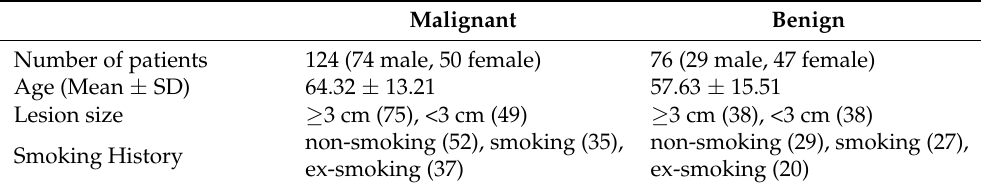
Table 1. Clinical details of the